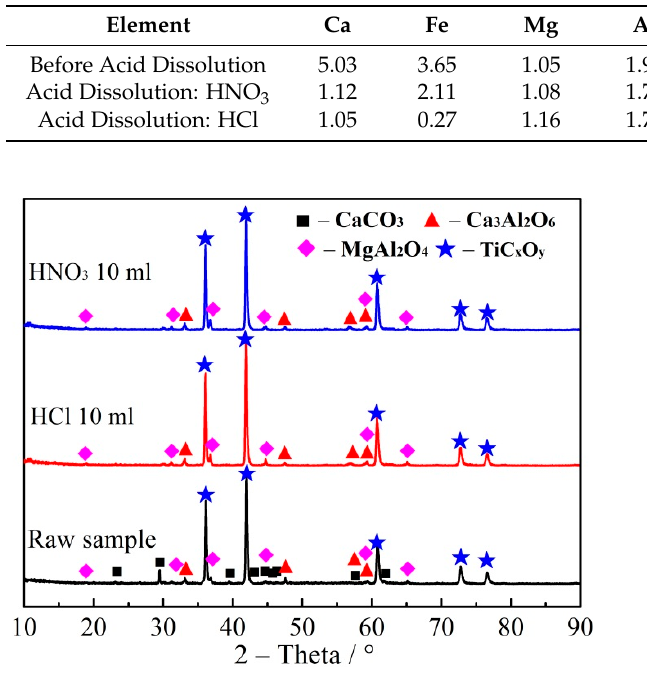
Figure 12. XRD patterns of products after removal of impurities by hydrochloric and nitric